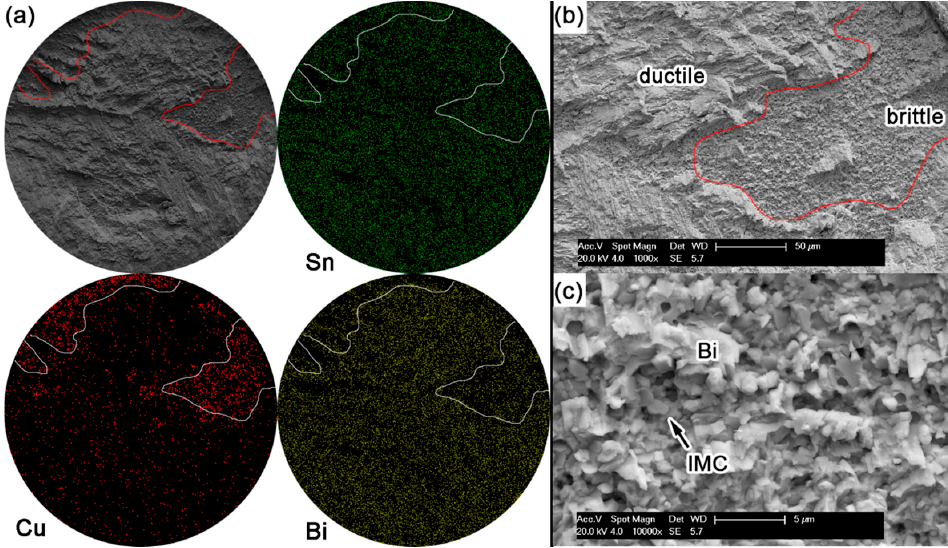
Figure 15. Fracture morphology of as-soldered Sn-58Bi solder bump: ( a ) SEM image and elemental mapping; ( b ) higher magnification on fracture surface with the observation of ductile solder and brittle interface; and ( c ) higher magnification on the brittle area in image ( b